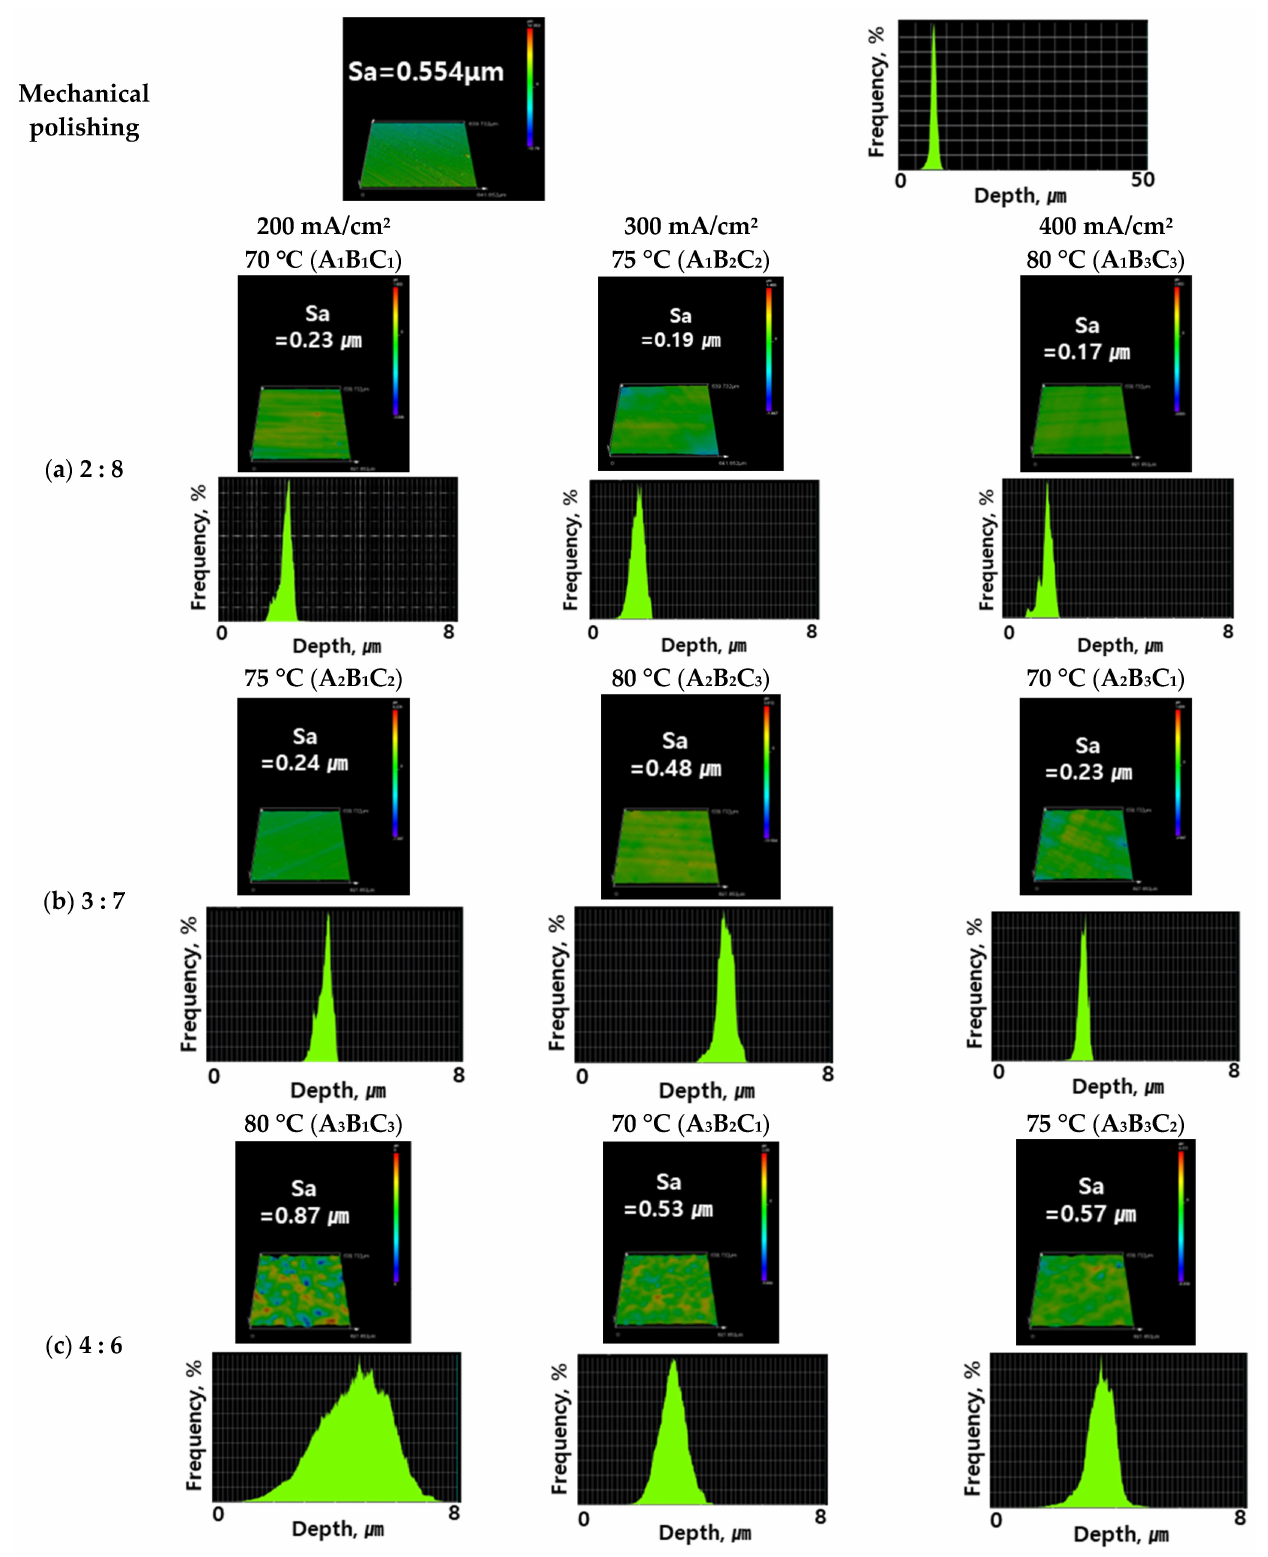
Figure 6. 3D analysis and depth histogram of damaged surfaces after electropolishing in an electrolyte containing sulfuric acid (95 wt%) and phosphoric acid (85 wt%). A 1 B 3 C 3 : The mean and spread are the smallest , A 3 B 1 C 3 : The mean and spread are the